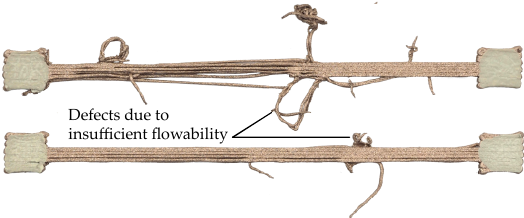
Figure 3. Representation of defects due to insufficient flowability using the example of M3D.